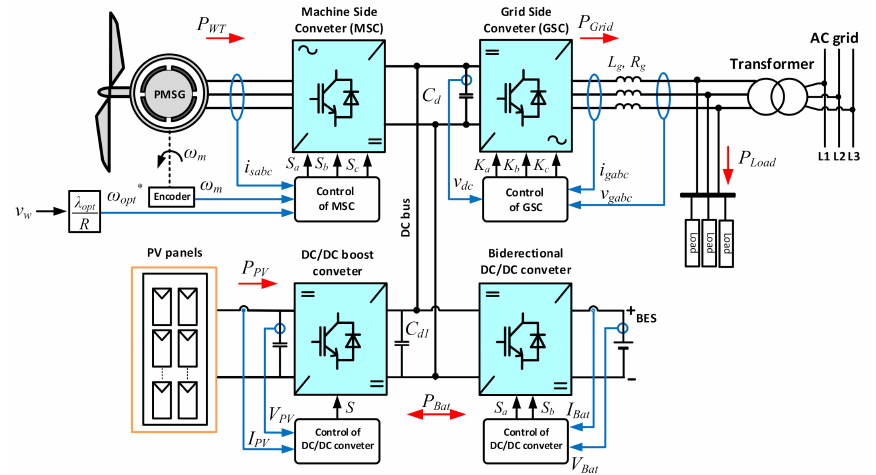
Figure 3. The detailed converter scheme of HRES with common DC bus and with Wind Energy Conversion Systems (WECS), Photovoltaic (PV), and Battery Energy Storage (BES)